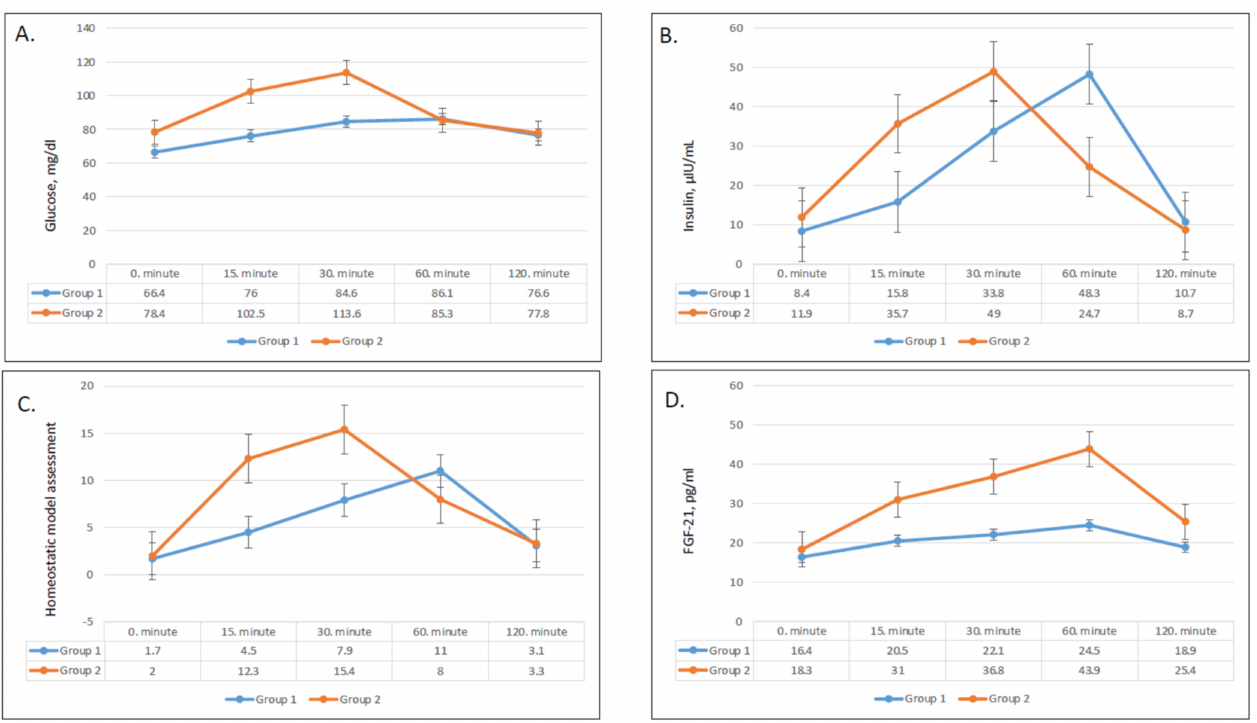
Figure 2. Changes in plasma glucose ( A ), plasma insulin ( B ), HOMA-IR (homeostatic model assessment) ( C ), and FGF-21 (fibroblast growth factor 21) ( D ) values in group 1 and group